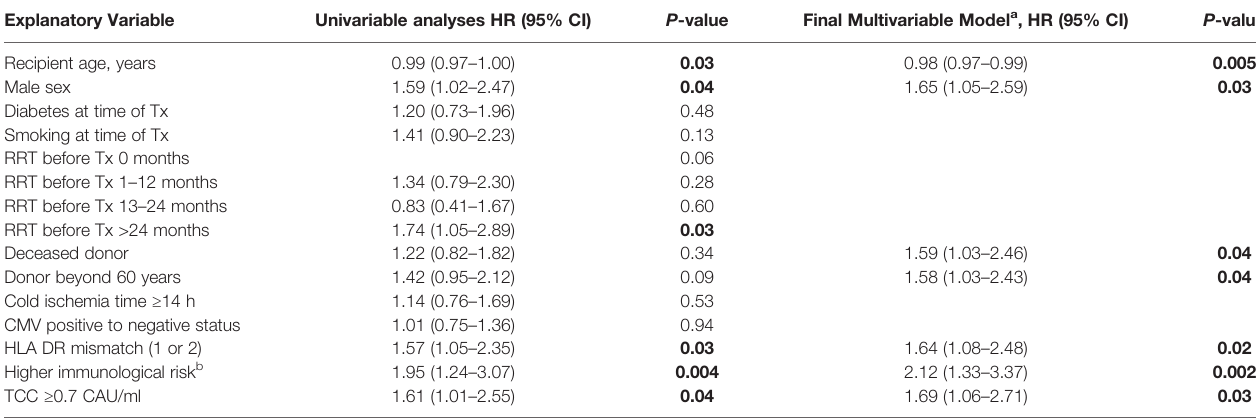
TABLE 4 | Univariable and multivariable Cox regression models with TCC for death-censored graft survival after kidney transplantation 2007 – 2012, n = 900. Explanatory